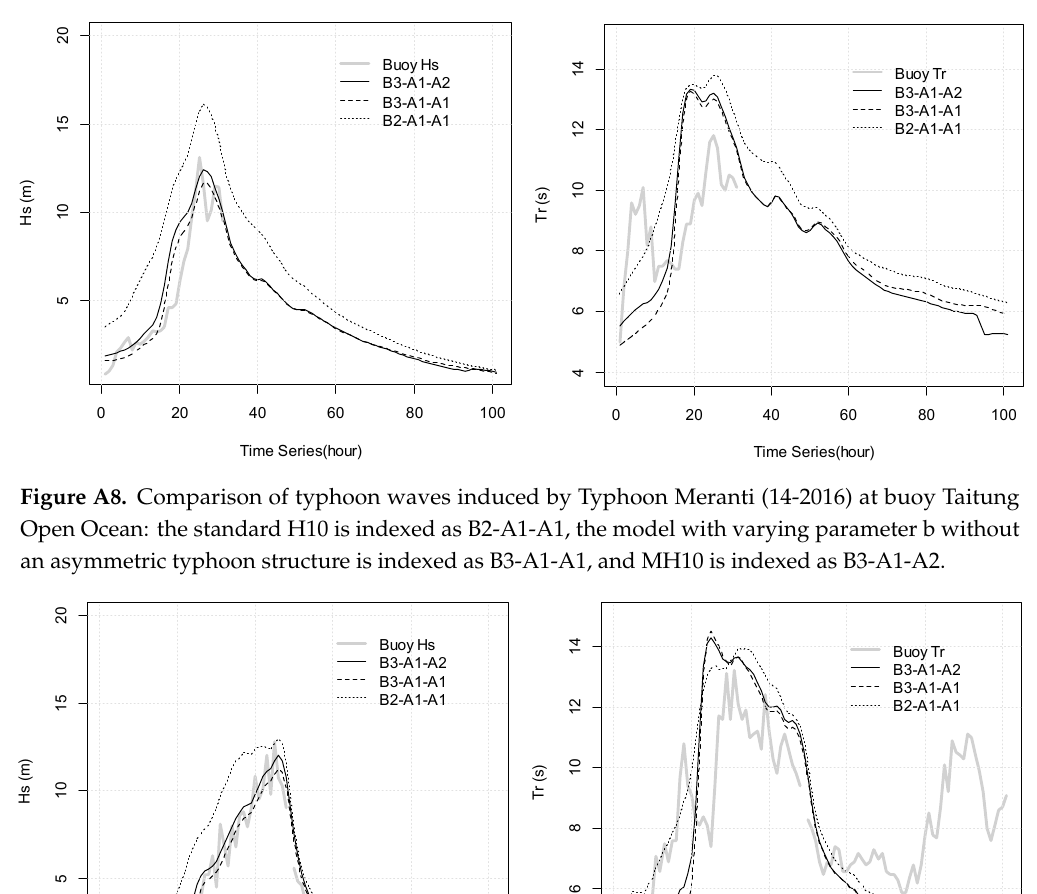
Figure A7. Comparison of typhoon waves induced by Typhoon Meranti (14-2016) at buoy Eluanbi: the standard H10 is indexed as B2-A1-A1, the model with varying parameter b without an asymmetric typhoon structure is indexed as B3-A1-A1, and MH10 is indexed as B3-A1-A2.